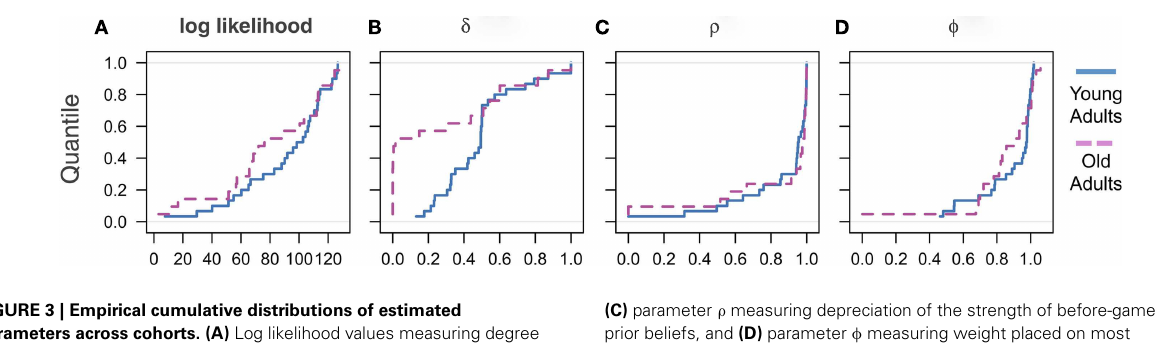
(C) parameter ρ measuring depreciation of the strength of before-game prior beliefs, and (D) parameter φ measuring weight placed on most recent